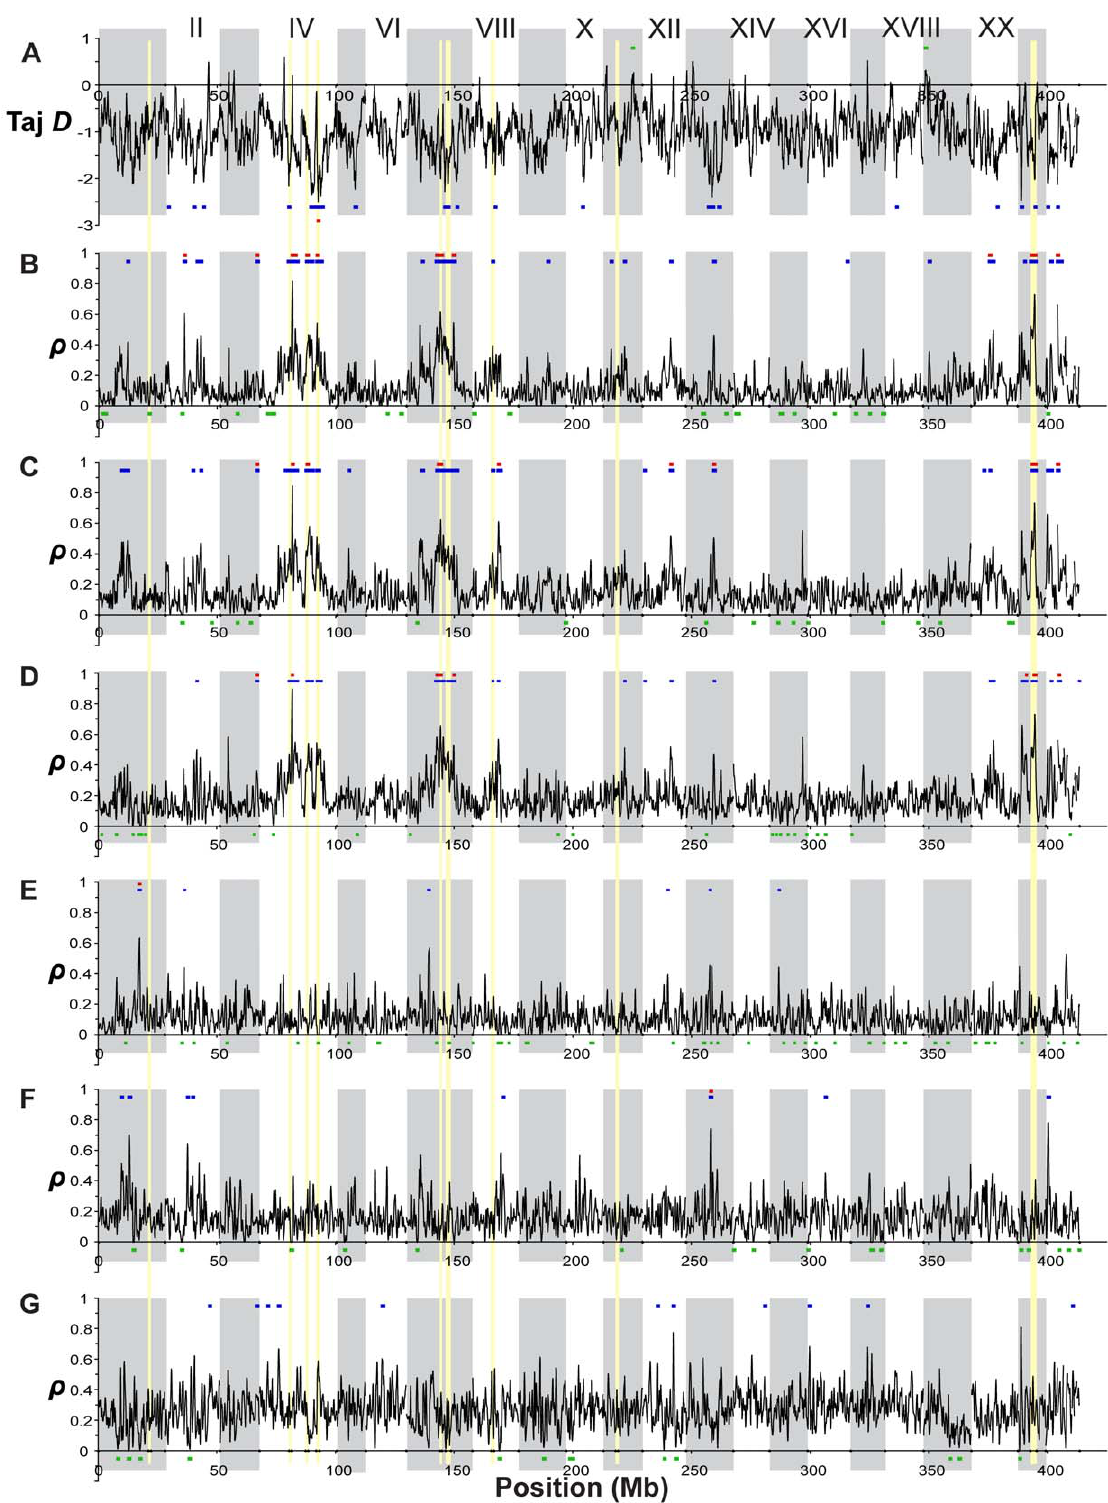
Figure 9. Genome-wide distributions of allele frequency spectrum and private allele density. (A) Tajima’s D , a measure of allele frequency spectrum, within the combined oceanic population (RS and RB). Colored bars above and below the distribution indicate regions of significantly elevated (p # 10 2 2 , green) or reduced (p # 10 2 2 , blue; p # 10 2 4 , red) values, assessed by bootstrap resampling. (B–G) Private allele density ( r ) in single freshwater populations. Colored bars indicate regions of significantly elevated (p # 10 2 3 , blue; p # 10 2 5 , red) or reduced (p # 10 2 3 ) values. (B) Private allele density in BP relative to combined oceanic populations (OC). (C) BL relative to OC. (D) ML relative to OC. (E) Private allele density in BP relative to other freshwater populations (FW). (F) BL relative to FW. (G) ML relative to FW. Across all panels, vertical gray shading indicates Linkage Groups I-XXI and unassembled scaffolds, and gold shading indicates the nine peaks of population differentiation highlighted in Figure 7 and Figure 8.